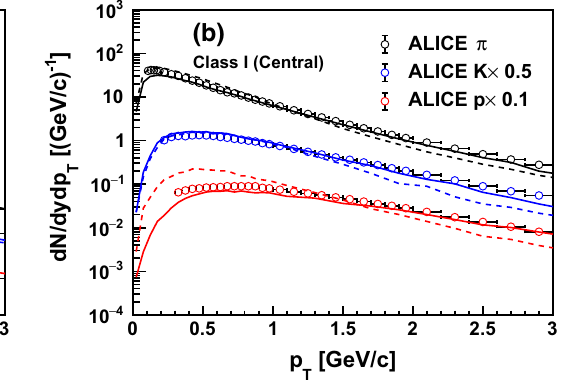
lations.Solidlinesrepresentourcurrentcalculationswith0.2mbparton rescattering cross section and final state hadron interactions. Dashed lines show AMPT calculations. ALICE data are taken from